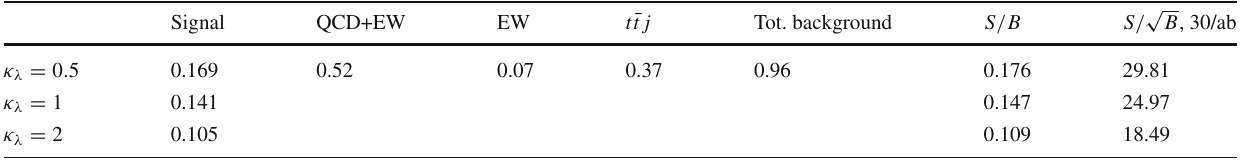
Table 3 Results of the h → τ (cid:3) τ h decay channels outlined in Sect. 2.3 in femtobarns (numbers to the left of the double vertical lines) after an optimised cut on the BDT output. We include results for three different